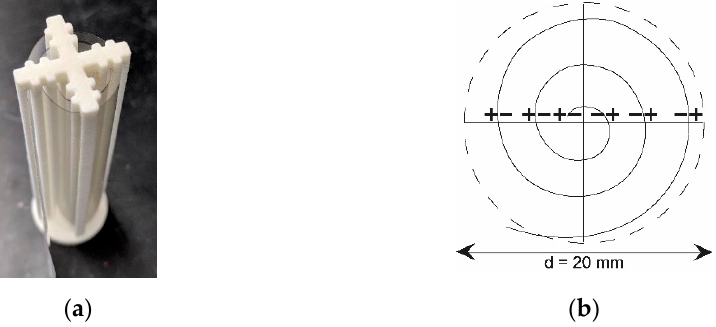
Figure 1. ( a ) REPS Sampler. ( b ) A top-view schematic showing the positioning of PVDF film inside the REPS film holder. The overlapping positive (+) and negative ( − ) film faces create an electrostatic field between the layers to attract and collect